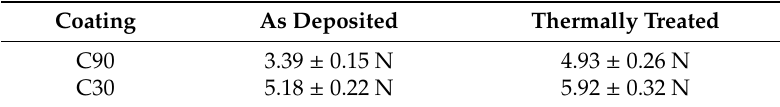
Table 4. Critical loads L C calculated from the friction–load curves for both coatings C30 and C90 before and after thermal